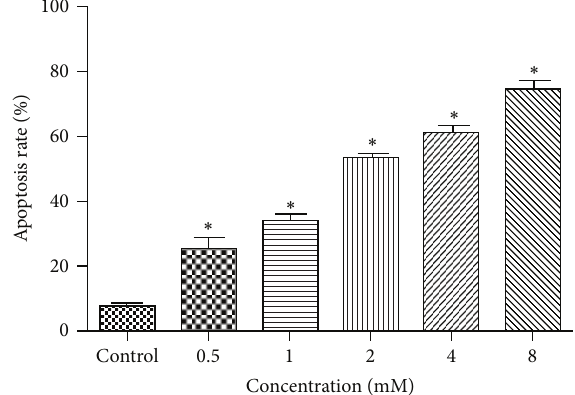
Figure4:InductionofapoptosisinTFK-1cellsbysodiumvalproate. TFK-1cellswereincubatedwith0–8 mMsodiumvalproatefor120 h. Apoptosis was measured by Annexin-V and PI double staining.